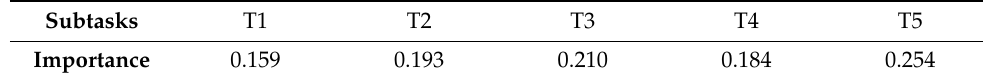
Table 2. The importance ranking of five subtasks. Subtasks